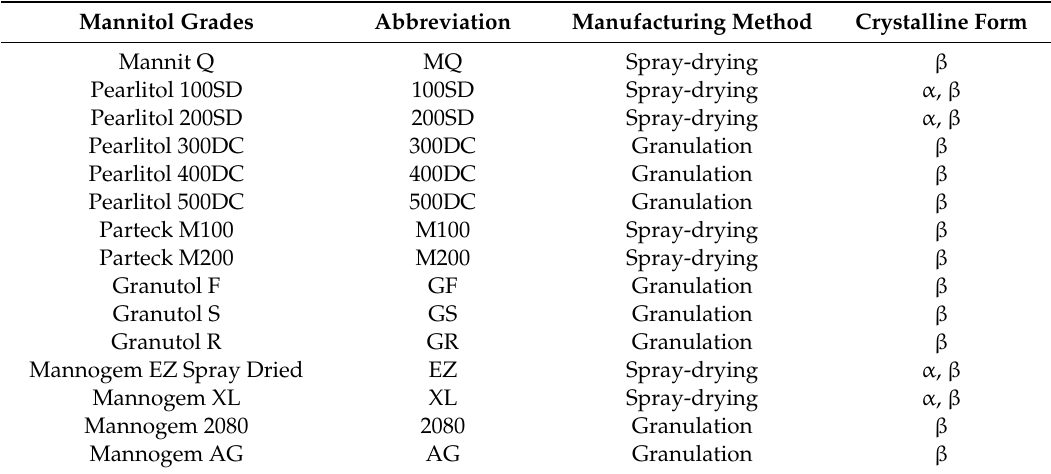
Table 1. Direct compaction grades of mannitol tested in this